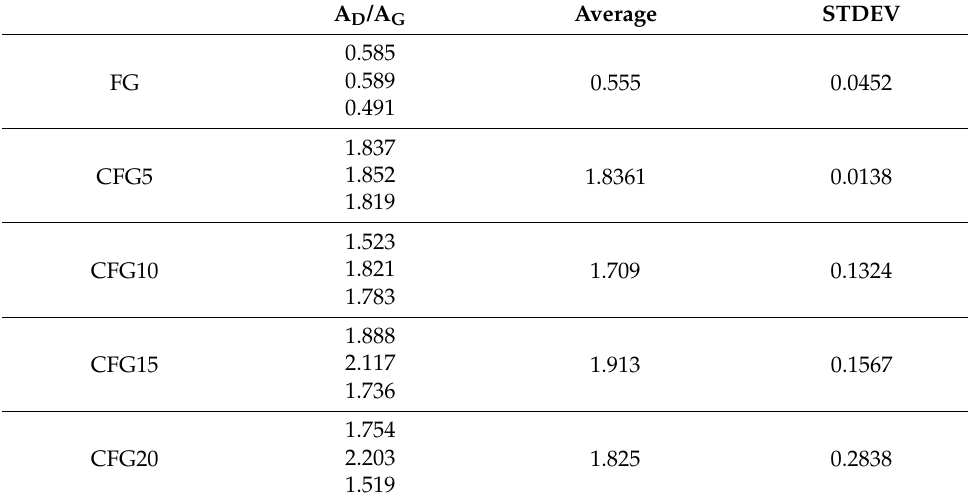
Table 2. The A D /A G derived from Raman